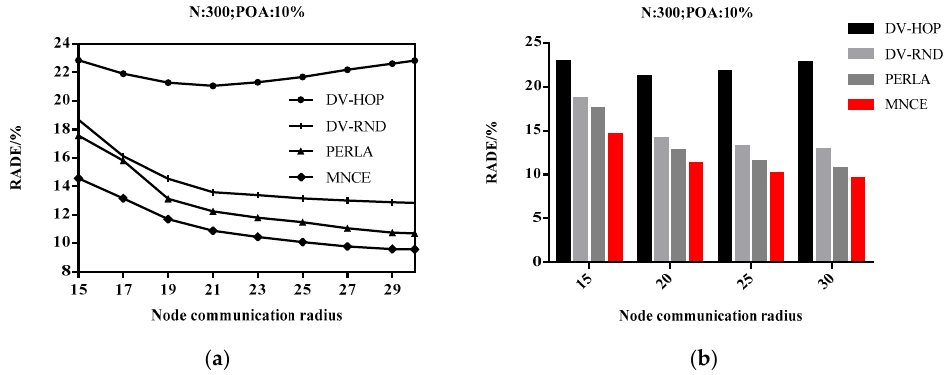
Figure 8. Impact of communication radius on RADE. ( a ) broken line diagram of the experimental results; ( b ) histogram of experimental significance values.